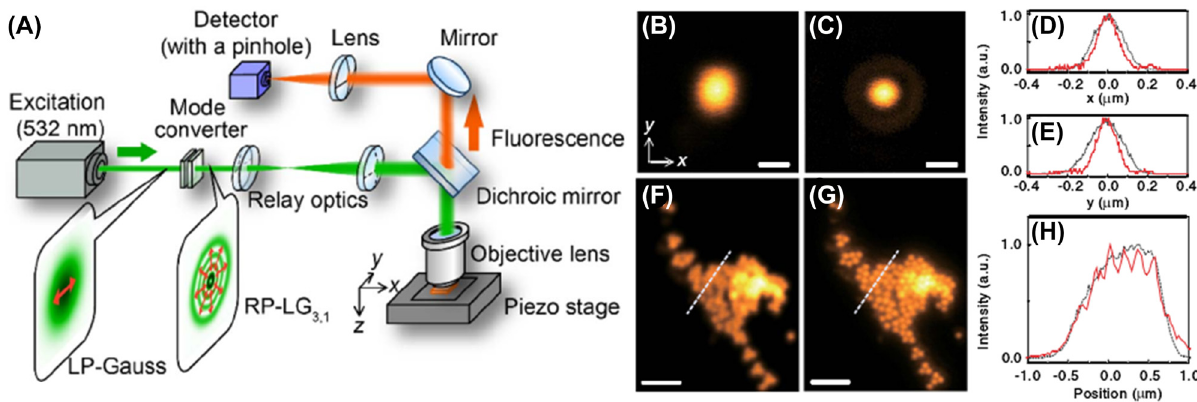
illumination based on a confocal laser microscope. Figure 12: Superoscillation imaging under RP-LG 3,1 illumination. (B) Measured PSFs (0.5 AU) for LPB with superoscillation. The (A) Sketch map of superoscillation imaging system under RP-LG 3,1 beam with superoscillation. The scale bar is 500 nm. (D) Intensity profiles for the scale bar is 500 nm. (C) Measured PSFs (0.5 AU) for RP-LG 3;1 measured PSFs along the x -axes shown in (B) and (C). (E) Intensity profiles for the measured PSFs along y -axes shown in (B) and (C). (F) beam (G) illumination, respectively. The Image of clusters of fluorescent beads with diameters of 170 nm acquired under LPB (F) and RP-LG 3;1 scale bars in (F, G) are both 1 μ m. (G) Intensity profiles along the dashed lines in (F) and (G). The black dashed and red solid lines in (D), (E), beam, respectively. Adapted from Ref. [90]. Copyright 2018 Optical Society of America under the and (H) correspond to LPB and RP-LG 3;1 terms of the OSA Open Access Publishing